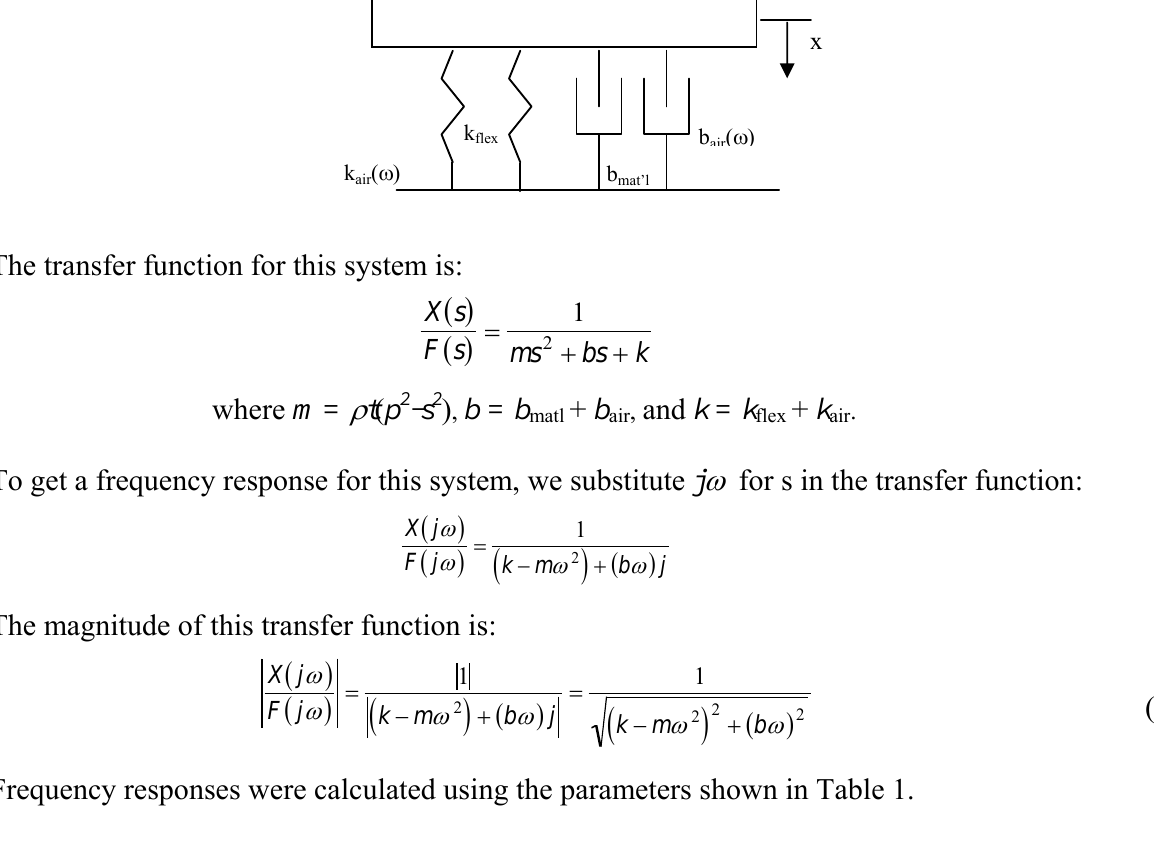
Table 1. Parameters used to simulate air damping model for square plate with square